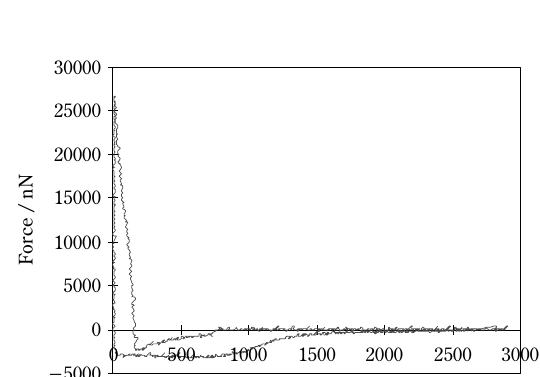
Fig. 2 Force-separation curve for the interaction between a glass microsphere (diameter (cid:2) 40 µ m) and a flat glass surface at RH (cid:2) 54%.